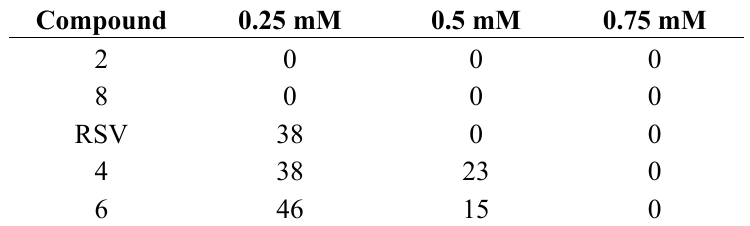
Table 1. Effects of stilbenes ( RSV and compounds 2 , 4 , 6 and 8 ) on the mobility of P. viticola zoospores. Values correspond to the percentage of mobile zoospores released by sporangia in a suspension added by stilbenes (0.25, 0.5, and 0.75 mM). The value of 100 was attributed to the number of mobile zoospores determined in the water